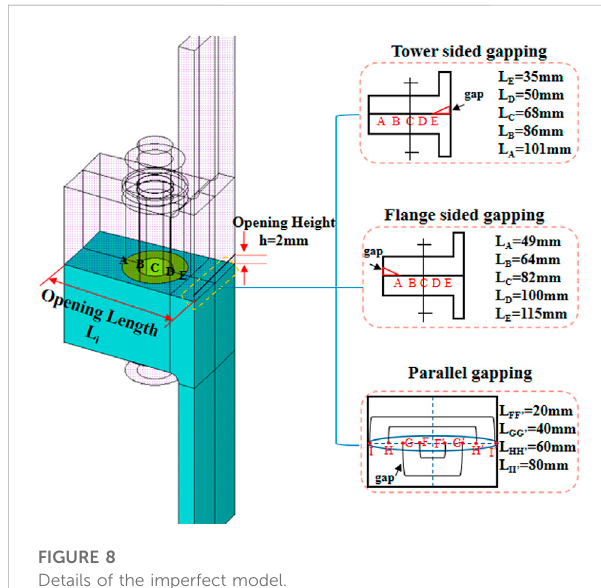
FIGURE 8 Details of the imperfect model.